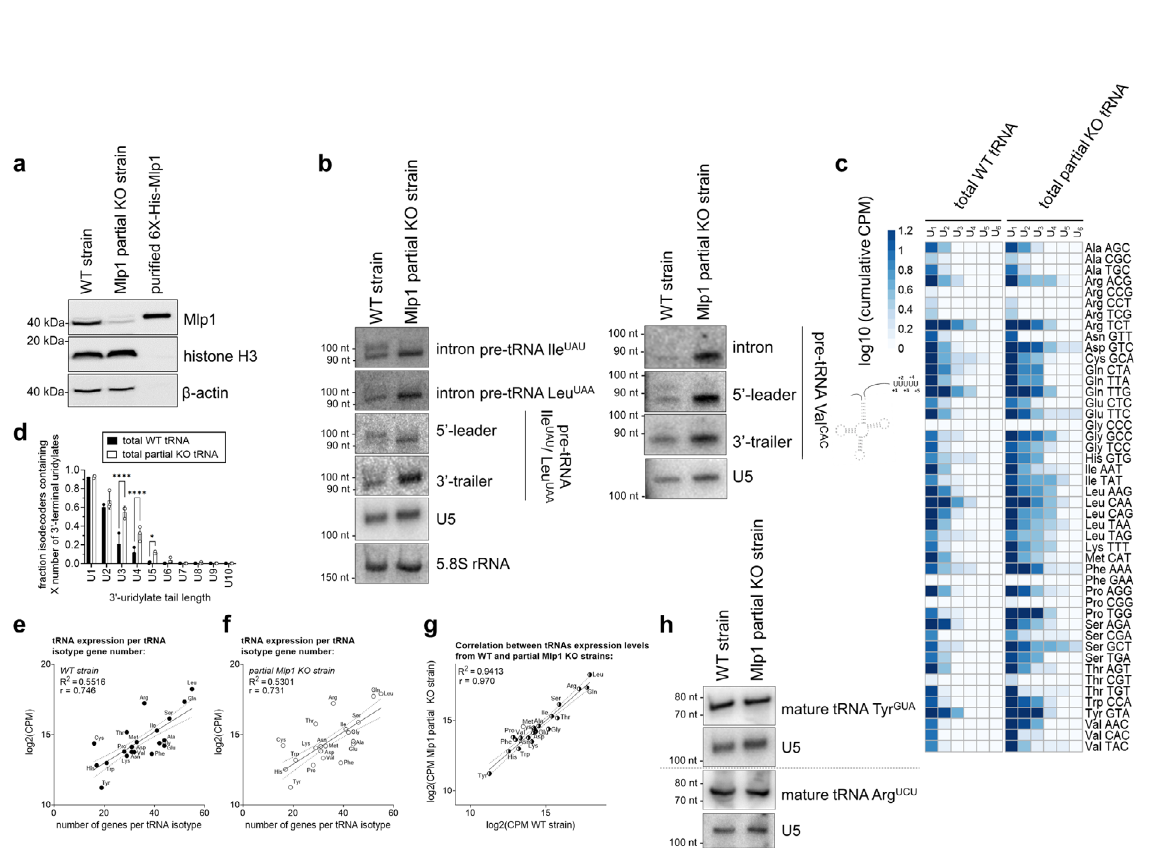
Fig. 5 | Depletion of Mlp1 results in altered pre-tRNA processing in T. thermo- phila with normal levels of mature tRNAs. a Western blot con fi rming decreased protein expression of Mlp1 in the partial Mlp1 knockout (KO) strain compared to thewild-type(WT)strain( n =3biologicallyindependentsamples).Loadingcontrol: histone H3 and β -actin. Puri fi ed 6X-His-Mlp1 was analyzed to control for